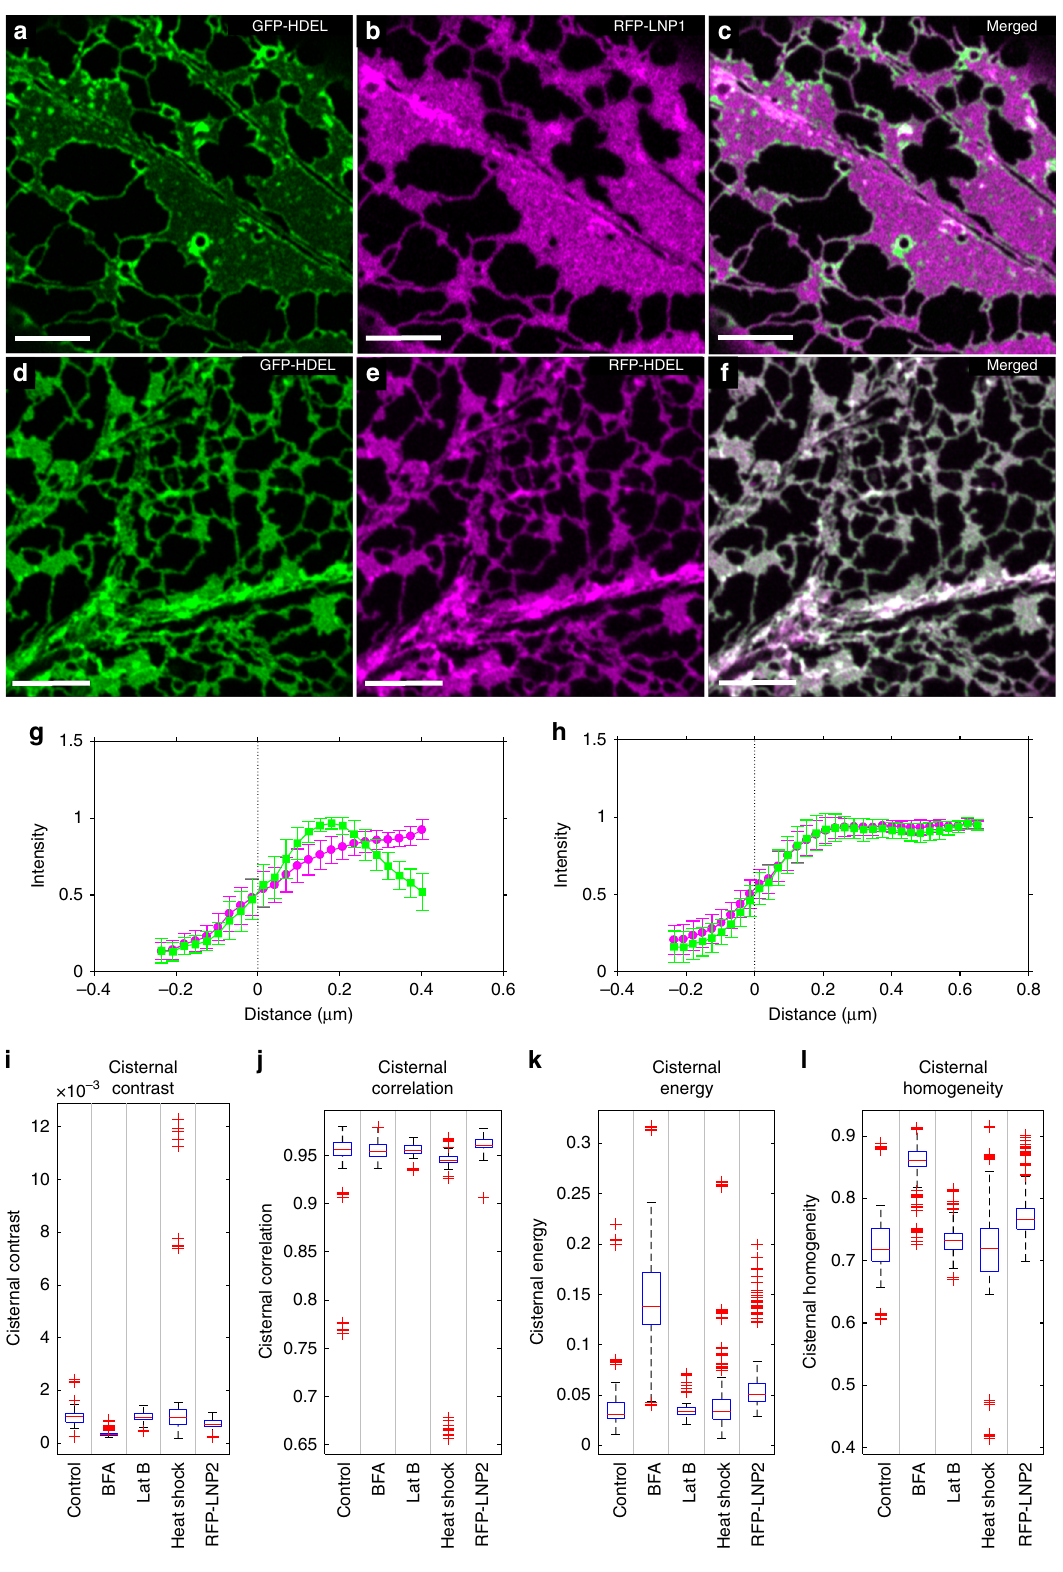
from the trace along a single tubule (Fig. 2c), between the yellow arrows shown in (Fig. 2a), where accumulation of RFP-RTN1 (magenta) caused a reduction in GFP-HDEL (green). In general, bulges in GFP-HDEL occurred every ~1 µm and peak intensity and width were not statistically different in the presence or